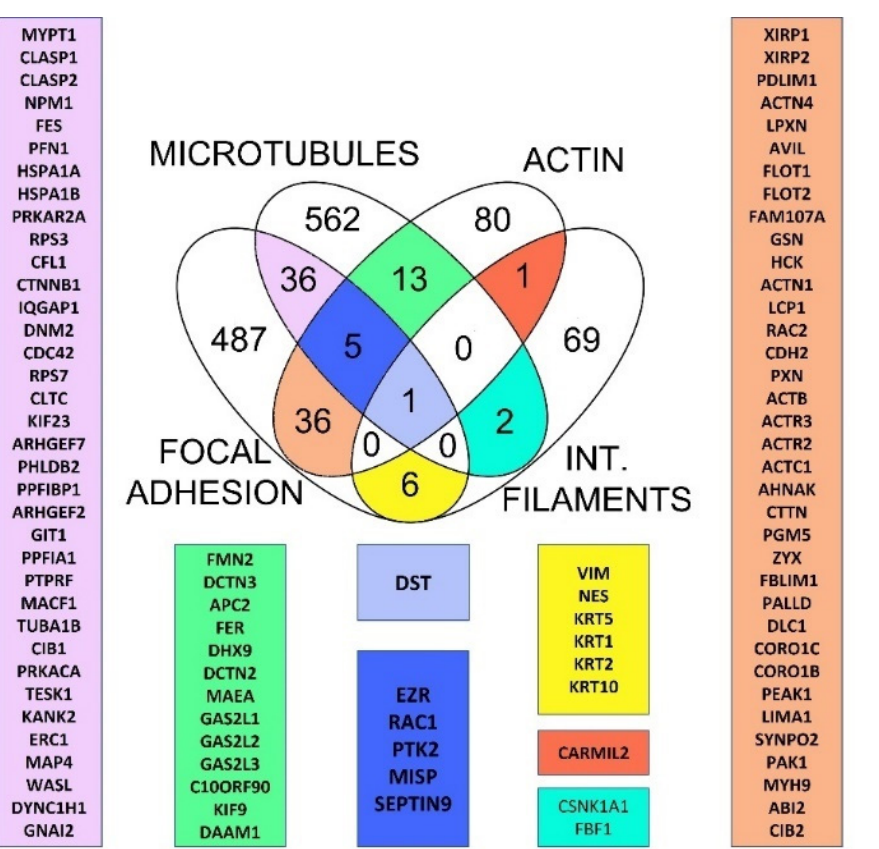
Figure 1. Putative cytoskeletal crosstalk proteins in humans. Venn diagram depicting 100 common proteins when using different datasets related to microtubules (MT), focal adhesions (FA), intermediate filaments (IF), and actin filaments. Dystonin (purple) was found in all datasets, whereas crosstalk proteins found in the MT, FA, and actin datasets are shown in a dark blue rectangle. Proteins at the crossing points between MT and FA (pink), MT and actin (green), FA and actin (beige), IF and MT (light blue), IF and actin (red), IF and FA (yellow) were generated as described in the Section 4. DST is important for maintaining the integrity of FAs and plays a key role in cell- substrate adhesion and cell spreading [33]. Moreover, it has been found to localize with hemidesmosomes in a region where keratin filaments are associated with hemidesmosomal plaque [34]. Additionally, DST interacts directly with MTs and their plus-end proteins EB1 and EB3